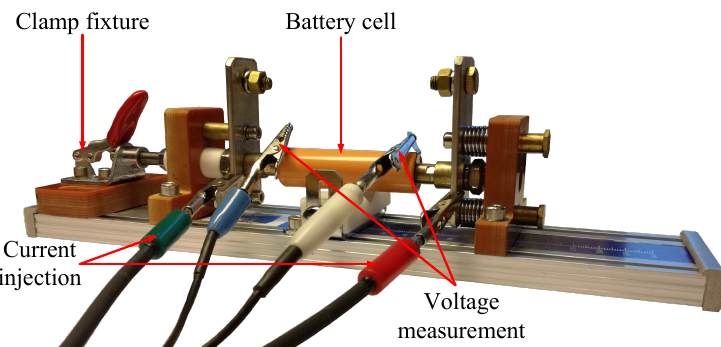
Figure 3. Battery cell testing of a cylindrical 18650 battery cell [25].